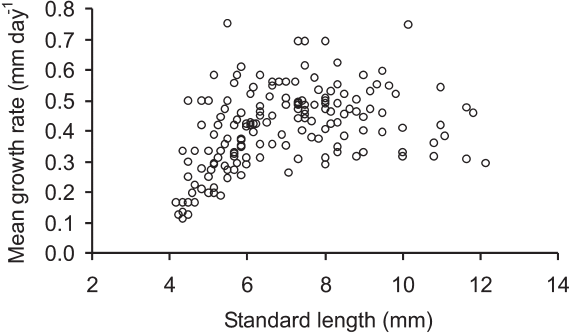
Fig . 6. – Scatter plot of the standard length and recent growth rate estimated from the last four increments of the otoliths (G4).